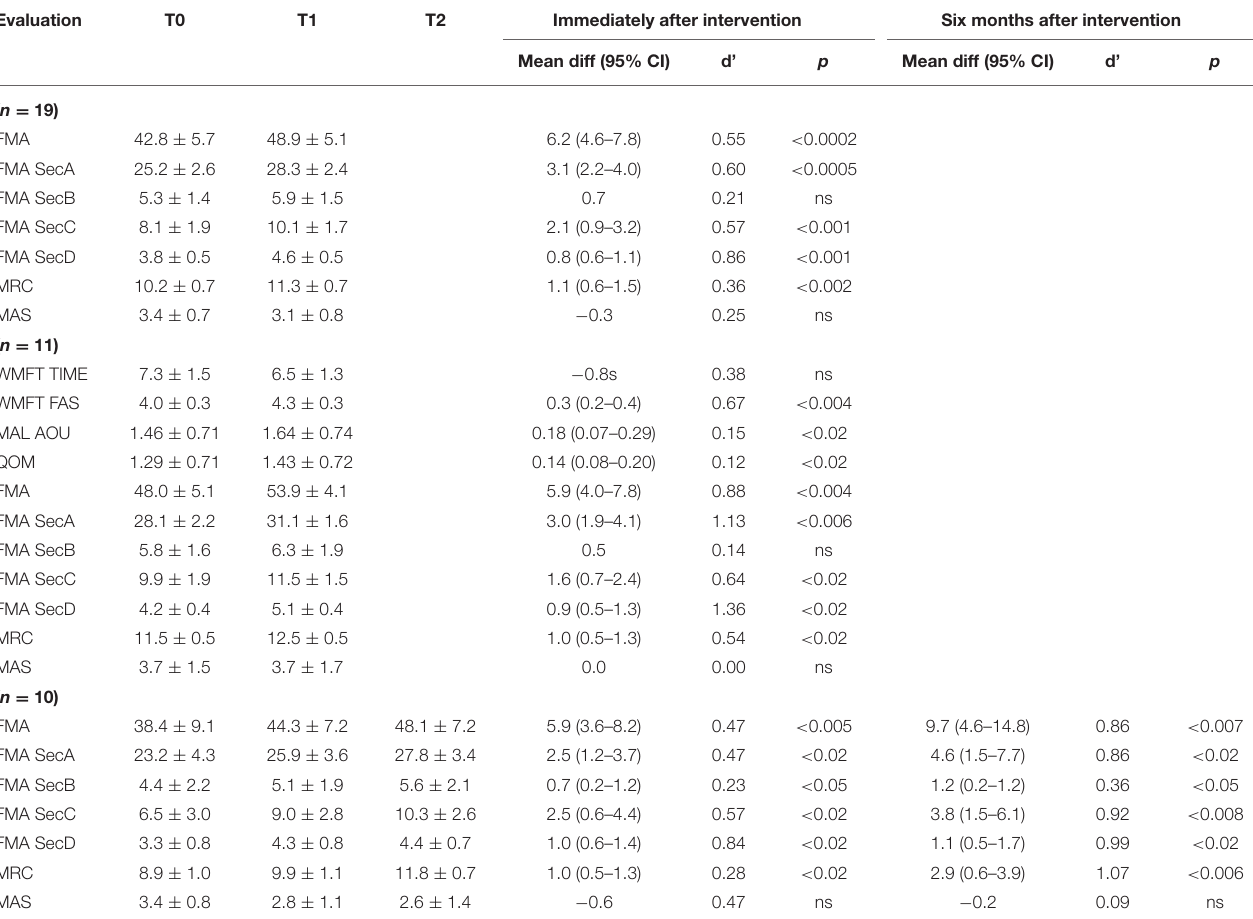
The table is in 3 parts: (1) FMA of 19 patients at T0 and T1; (2) WMFT and MAL at T0 and T1 of a subgroup of 11 patients (along with FMA to define the level of impairment) and (3) FMA at T0, T1 and T2 of a subgroup of 10 patients. MRC and MAS are shown to complete the patients’ clinical picture. FMA, Upper-Extremity Fugl-Meyer Assessment (max 66 pts); SecA, Shoulder and Elbow Section (max 36 pts); SecB, Wrist Section (max 10 points); SecC, Hand Section (max 14 pts); SecD, Coordination/Velocity Section (max 6 pts); MRC, Medical research Council (max 15 points); MAS, Modified Ashworth Scale (max 15-negative points); WMFT, Wolf Motor Function Test; TIME, average duration (s) to perform items; FAS, Functional Ability Scale (max 5 pts): MAL, Motor Activity Log; AOU, Amount of Use (max 5 points); QOU, Quality Of Use (max 5 pts).